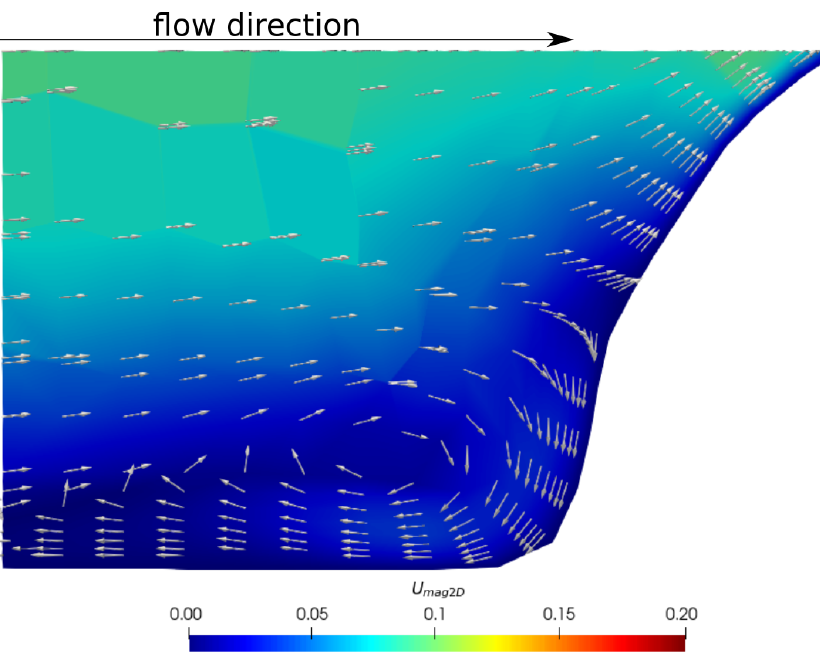
Figure 16. Two-dimensional velocity combined with vector arrows in front of the rib to show the backflow that takes place